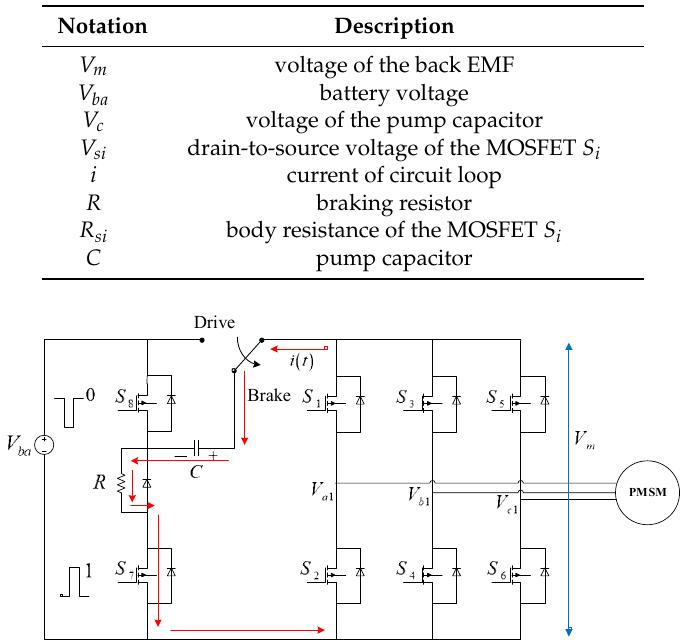
PMSM BrakeDrive Figure 5. Current loop when the battery in series with the capacitor. Under the situation, the battery voltage (cid:1848) (cid:3029)(cid:3028) will be in the series with the capacitor’s voltage (cid:1848) (cid:3030) . This boosts the main voltage to be (cid:1848) (cid:3029)(cid:3028) + (cid:1848) (cid:3030) . Referring to Figure 5, the braking current is the